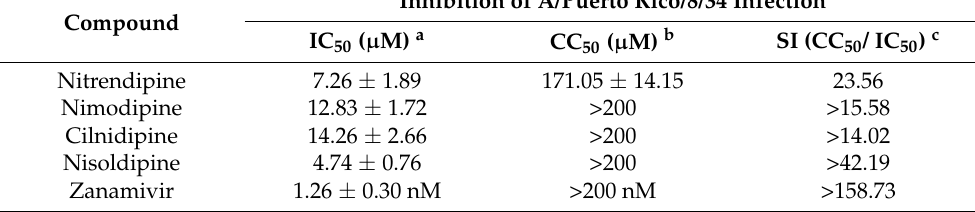
Table 1. Anti-influenza A virus activity of dihydropyridine calcium channel blockers (mean ± SD, n =